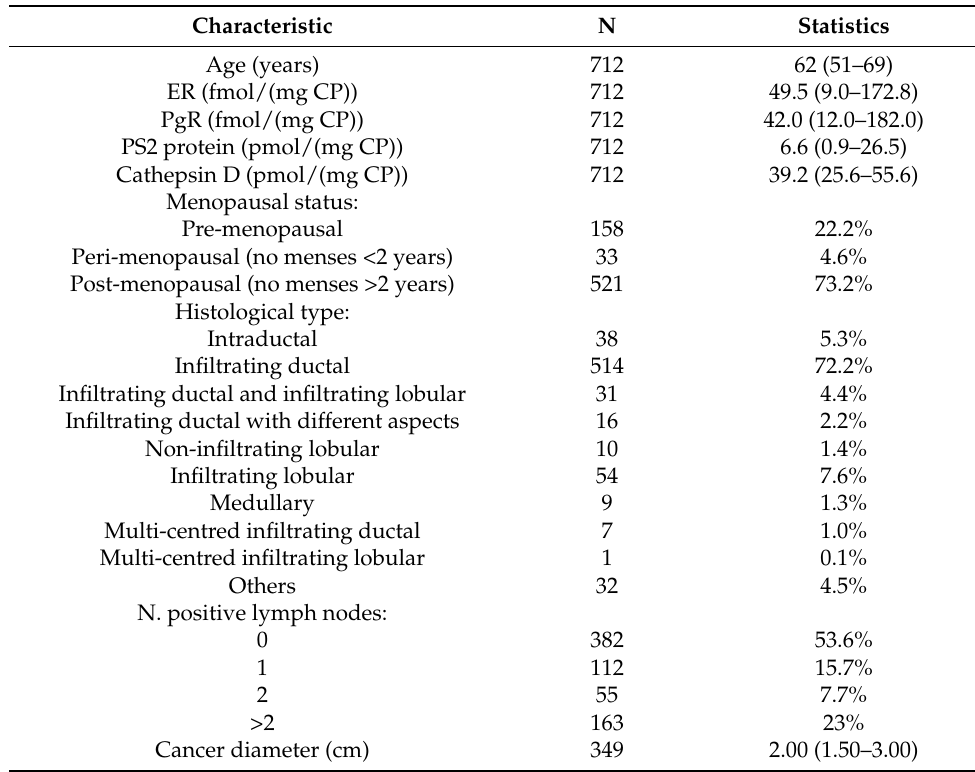
Table 2. Distributions of the variables in the sample. Continuous variables are represented with median values (1st quartile–3rd quartile). Categorical variables with percentages. N is the number of non-missing observations for each variable.